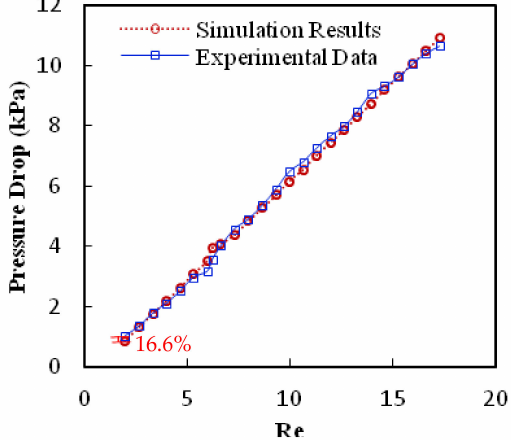
Figure 4. Validation results for Re versus pressure drop based on experimental data